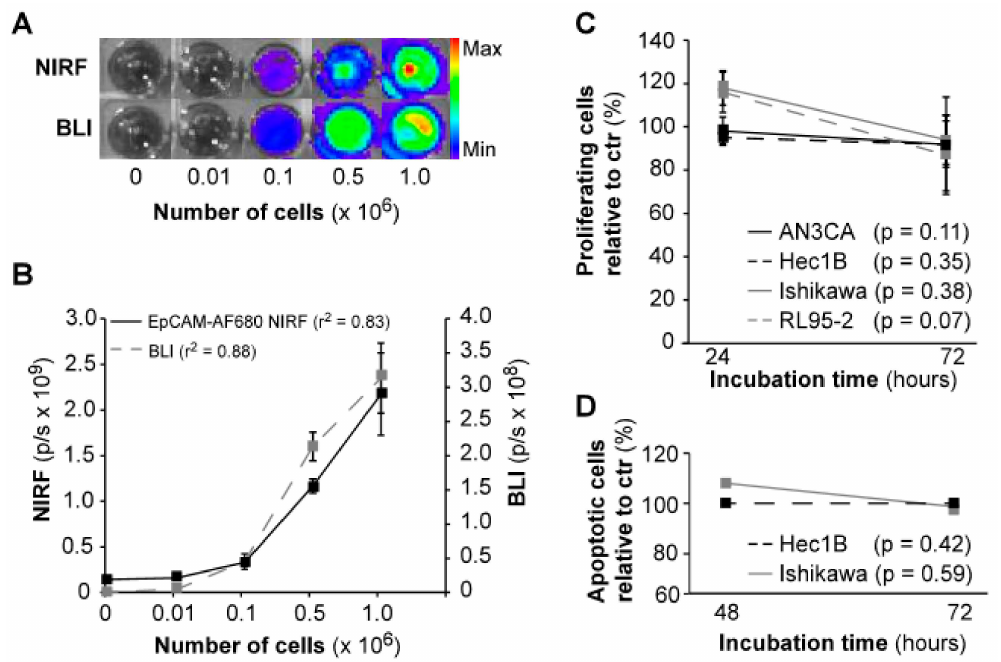
Figure 2. In vitro evaluation of EpCAM-AF680 as a NIRF imaging probe. In vitro imaging of Ishikawa luc + cells using BLI and EpCAM-AF680 NIRF demonstrates comparable photonic linearity ( A ) and increase in signal ( B ) with higher number of cells (range: 0–10 6 cells). The lack of significant e ff ects of in vitro incubation with EpCAM-AF680 antibody on proliferation and apoptosis demonstrated by MTS assay ( C ) and Annexin V / PI staining ( D ) in various cell lines. Abbreviations: Bioluminescent imaging (BLI), Epithelial cell adhesion molecule (EpCAM), Near-infrared fluorescent (NIRF), and Propium iodide